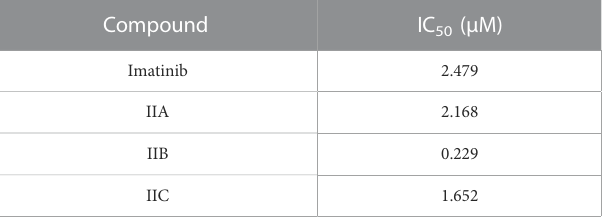
TABLE 4 IC 50 of the tested compounds (IIA, IIB, and IIC) against the A549 lung cancer cell line with imatinib as a